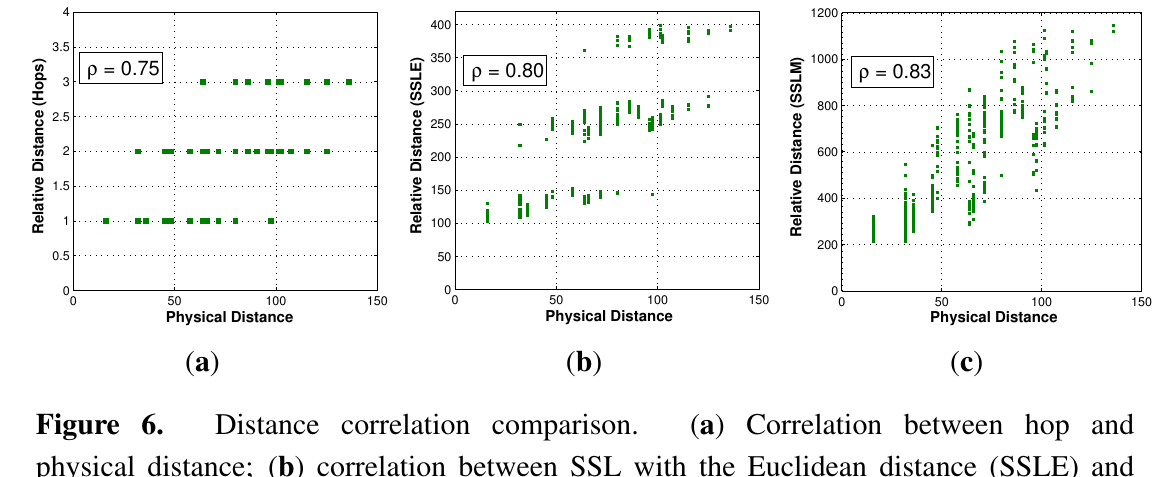
Figure 6. Distance correlation comparison. ( a ) Correlation between hop and physical distance; ( b ) correlation between SSL with the Euclidean distance (SSLE) and physical distance; ( c ) correlation between SSL with the Manhattan distance (SSLM) and physical